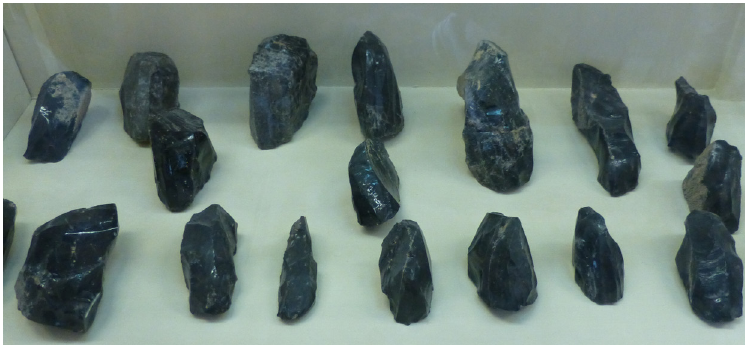
Figure 9. Selection of obsidian cores found on Lipari.